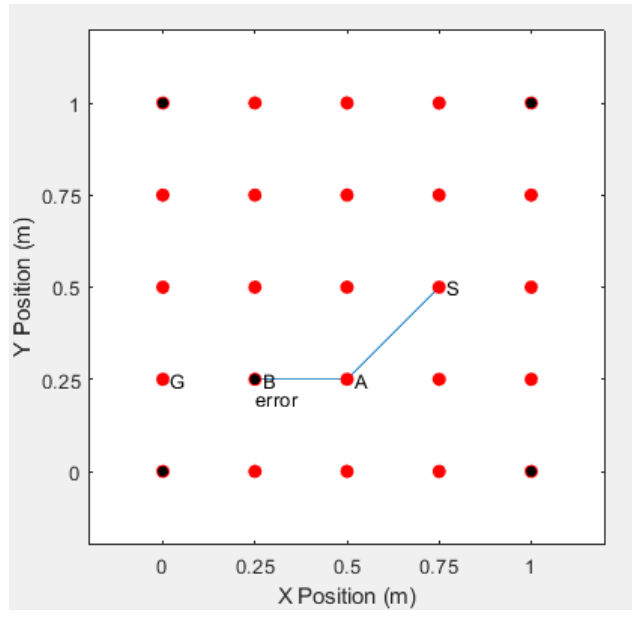
Figure 11. The Error Occurs the Node B.